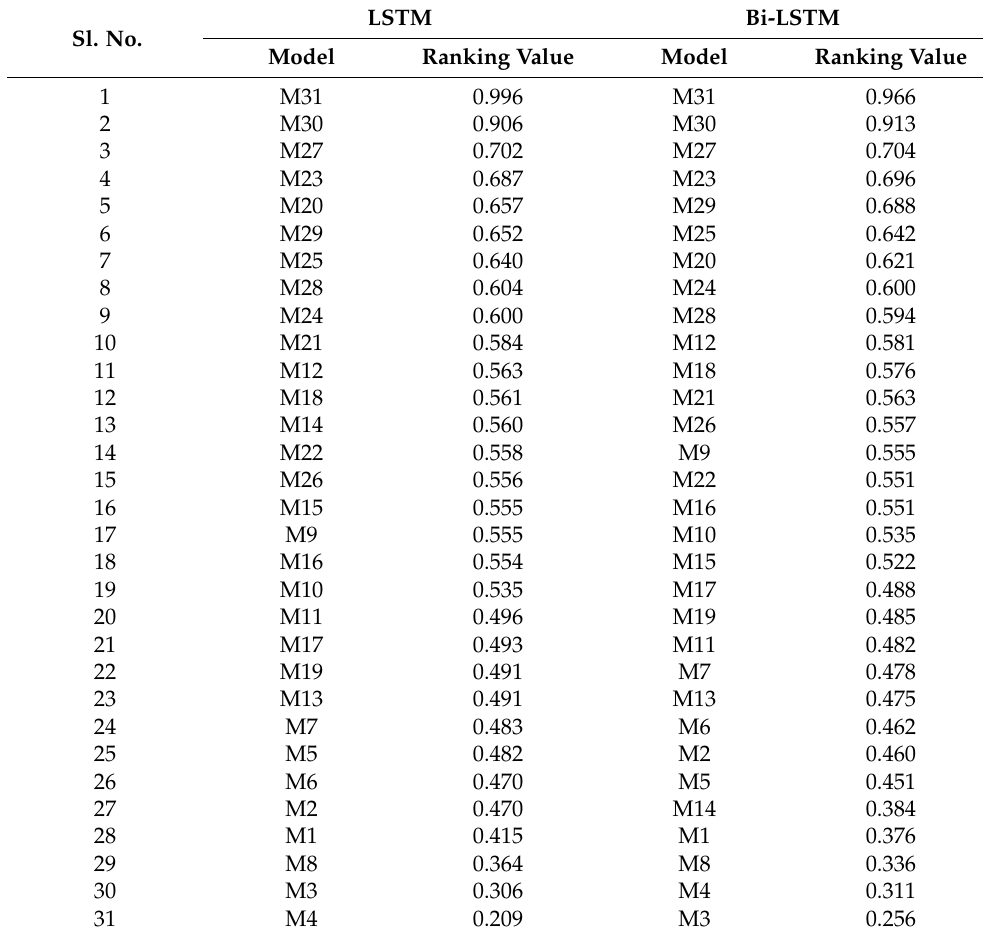
Table 6. Ranking of the LSTM and Bi-LSTM models using Shannon’s entropy. Sl.